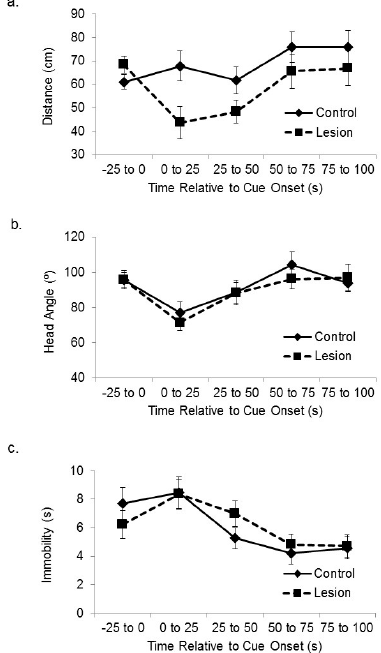
Figure 2. Hippocampus and cue-directed attention. ( a ) The distance between the subjects and the corner of the platform nearest the active speaker is plotted during the sensory preconditioning session, 100 s exposure to the auditory cue, and the immediately preceding baseline period. Subjects with lesions to the dorsal hippocampus approached the active speaker at cue outset more than control subjects; ( b ) The head angle relative to the location of the active speaker during the baseline period and cue exposure is plotted. There was no difference between groups in head orientation change towards the location of the auditory cue; ( c ) The number of seconds spent immobile during the baseline period and after cue onset is plotted. Subjects with lesions to the dorsal hippocampus were immobile for the same amount of time as controls. There was an effect of time after cue onset in which there was greater immobility soon after cue onset than in later periods.